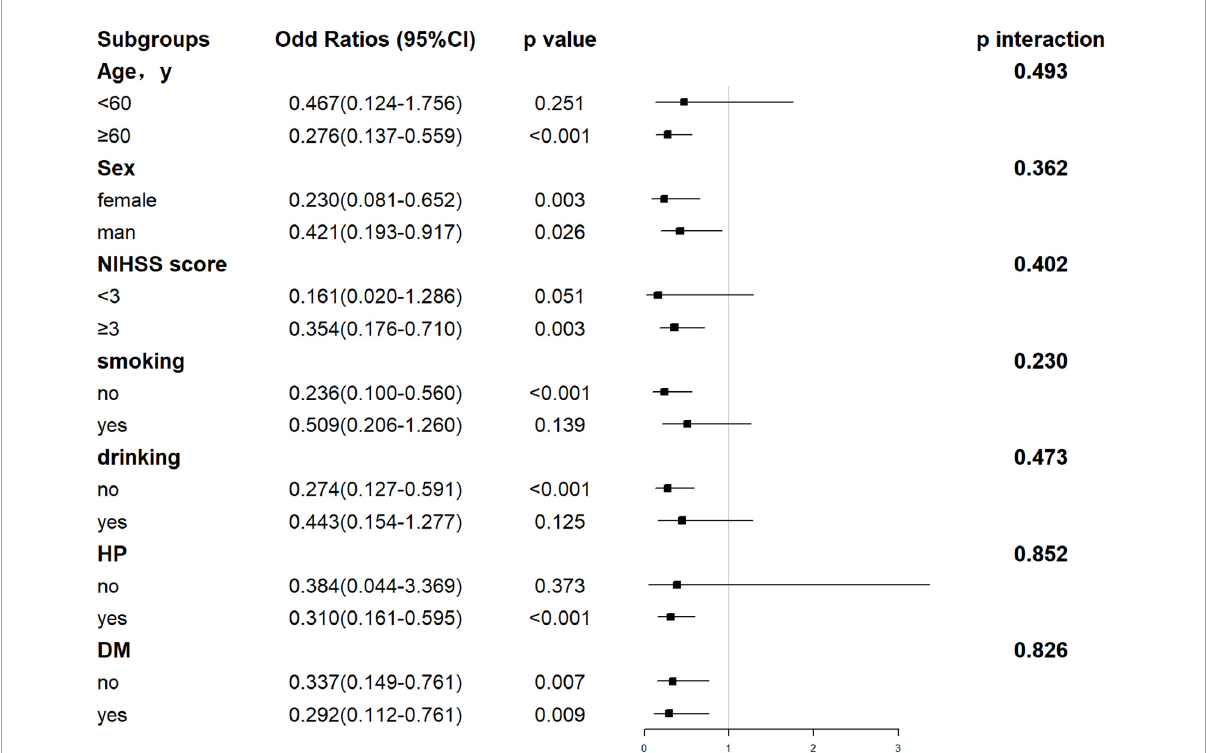
FIGURE5 Forest plot of subgroup analysis for the association between TP levels and functional outcome at 1 year. The TP becomes a dichotomous variable with the optimal cutoff value determined according to Youden’s index of the ROC curve. TP is divided into < 68.75 and ≥ 68.75 g/l. NIHSS, National Institutes of Health Stroke Scale; HP, hypertension; DM, diabetes mellitus; TP, total